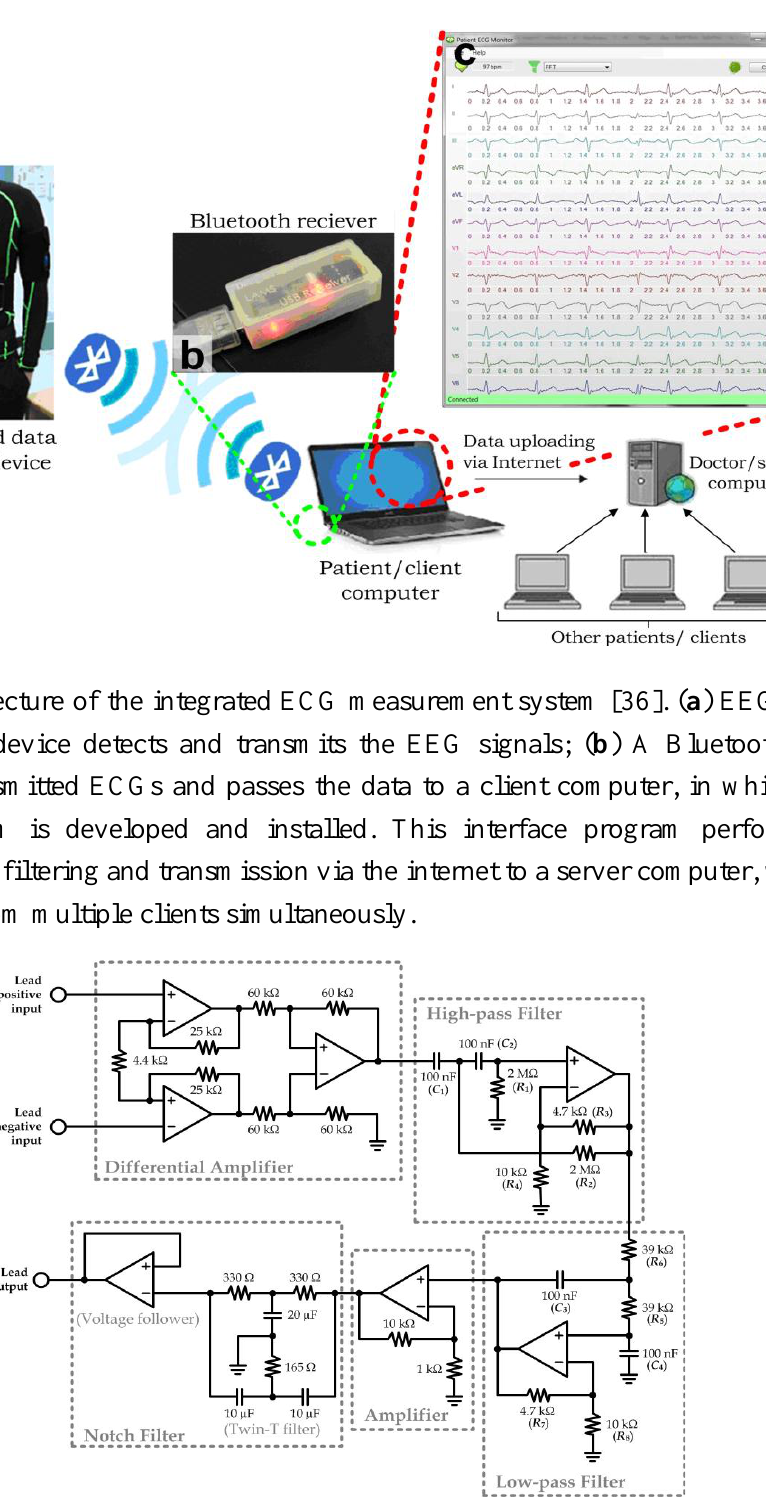
Figure 6. Circuit schematics for detection of each lead of the 12-lead ECG